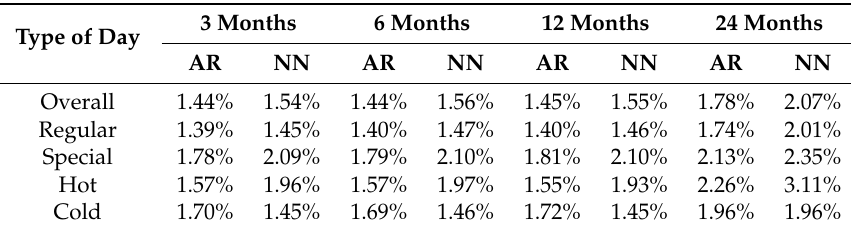
Table 7. Forecasting error (RMSE) with different training frequency.